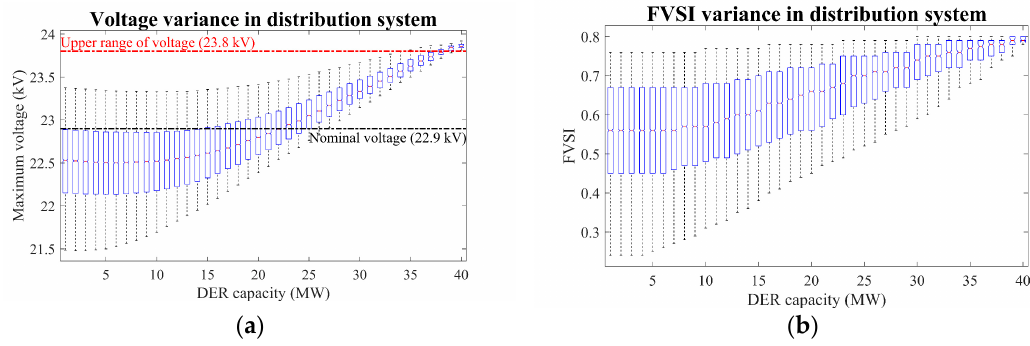
Figure 8. Results for distribution system: ( a ) voltage variance, ( b ) FVSI variance.